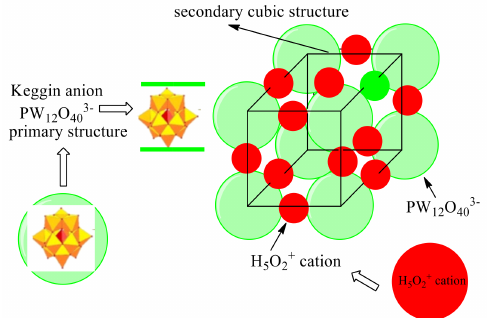
Figure 24. Primary and secondary structure of Keggin heteropolyacid H 3 PW 12 O 40 (adapted from [81]).